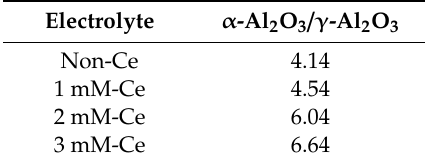
Table 3. X-ray di ff raction peak ratio of α -Al 2 O 3 and γ -Al 2 O 3 according to Ce ion.